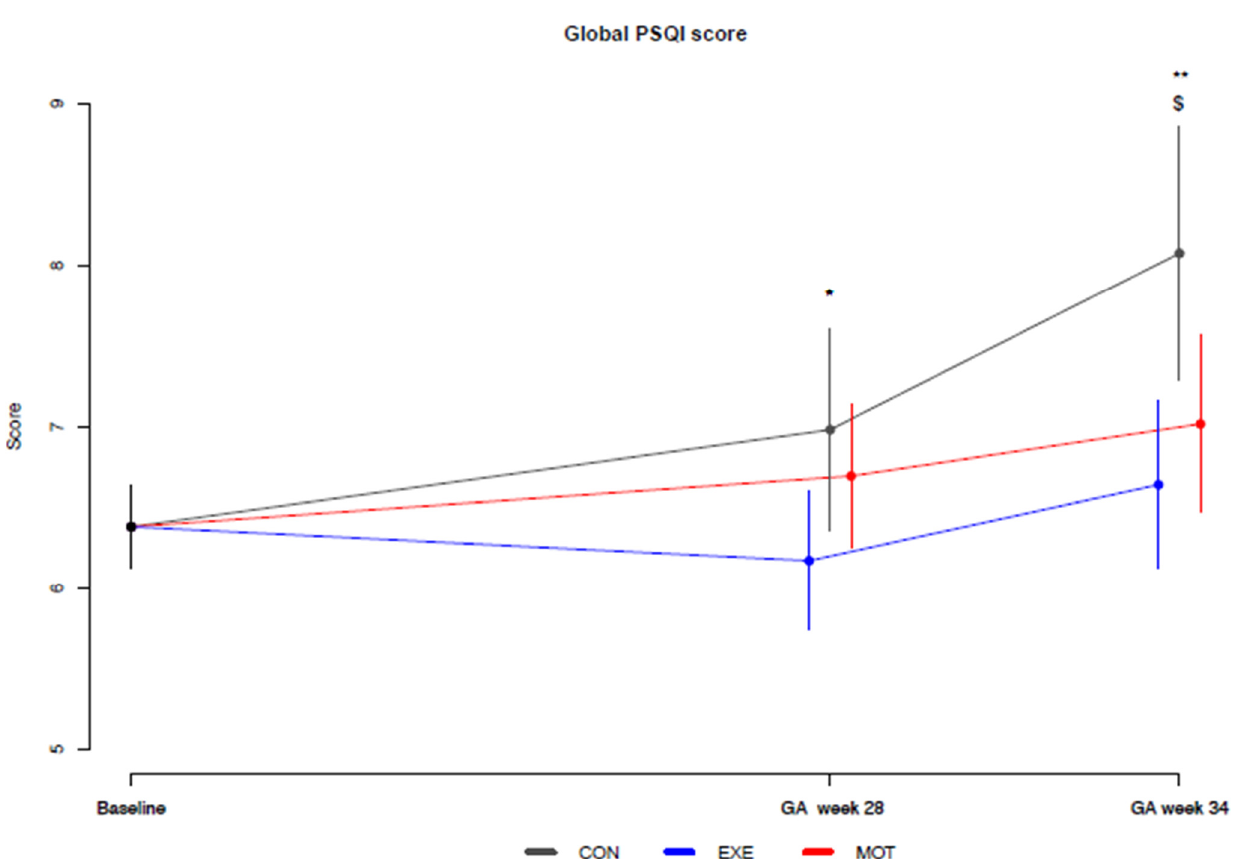
Figure 1. Baseline-constrained comparison between groups based on the means of the Pittsburgh Sleep Quality Index global score. Baseline, gestational age of maximum 15 weeks; CON (gray color), standard care; EXE (blue color), structured supervised exercise training; GA, gestational age; MOT (red color), motivational counseling on physical activity. * EXE compared to CON at GA week 28 ( p = 0.031), ** EXE compared to CON at GA week 34 ( p = 0.002), $ MOT compared to CON at GA week 34 ( p = 0.026).